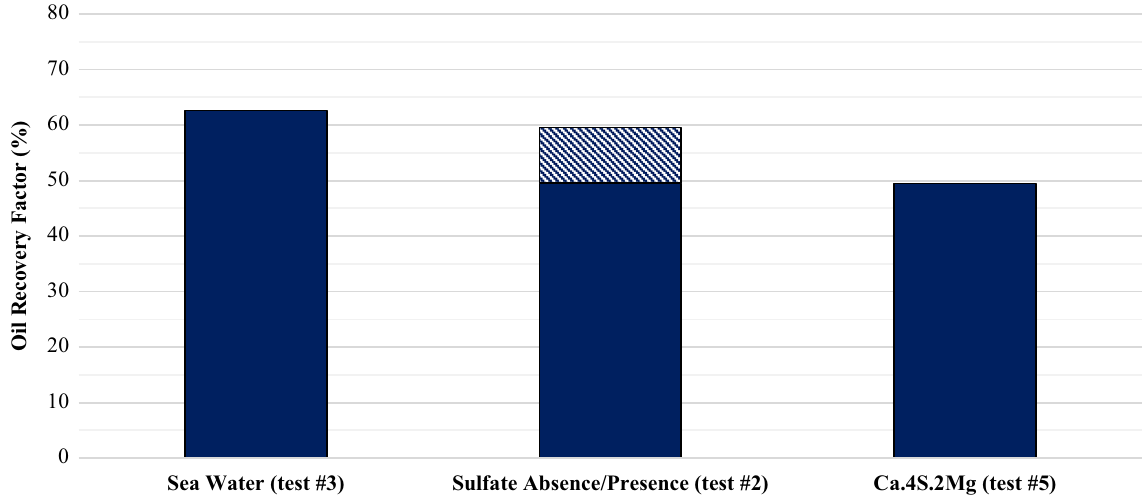
Fig. 7 Effect of SO 42− on oil recovery. In test #2, sulfate ion is first removed from the brine and then added to observe the effect of absence and presence of sulfate ion. Test #5 indicates the negative impact of adding SO 42− compared to